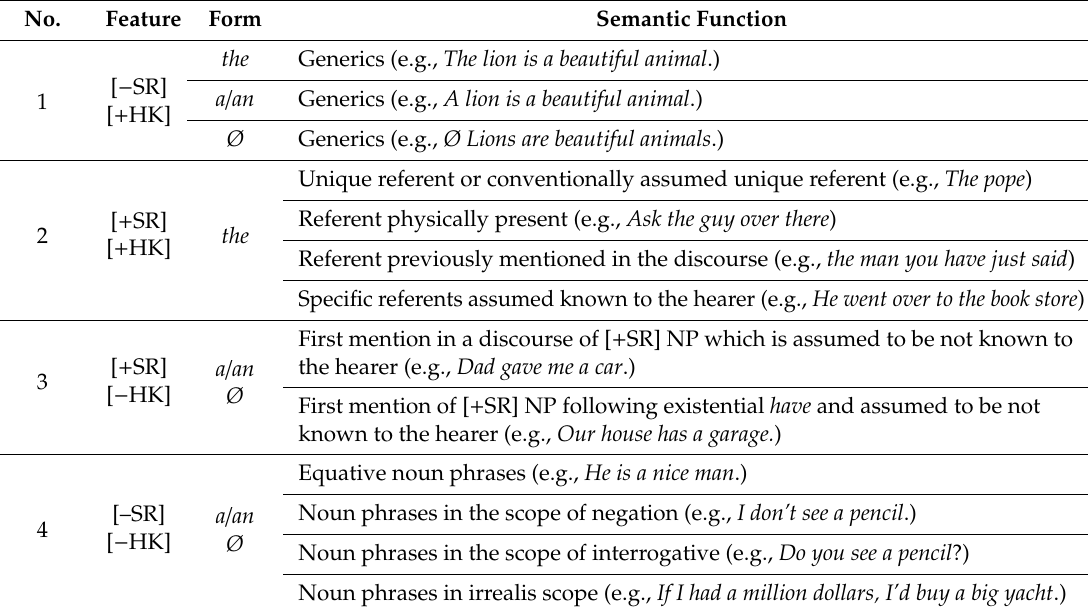
Table 1. Four Noun Phrase (NP) Categories and Semantic Functions (Tarone and Parrish 1988). SR = Specific referent; HK = Hearer